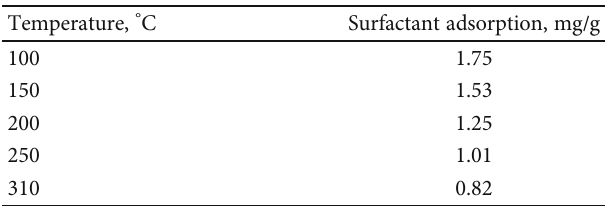
Table 2: E ff ects of temperature on surfactant adsorption on a sandstone rock.